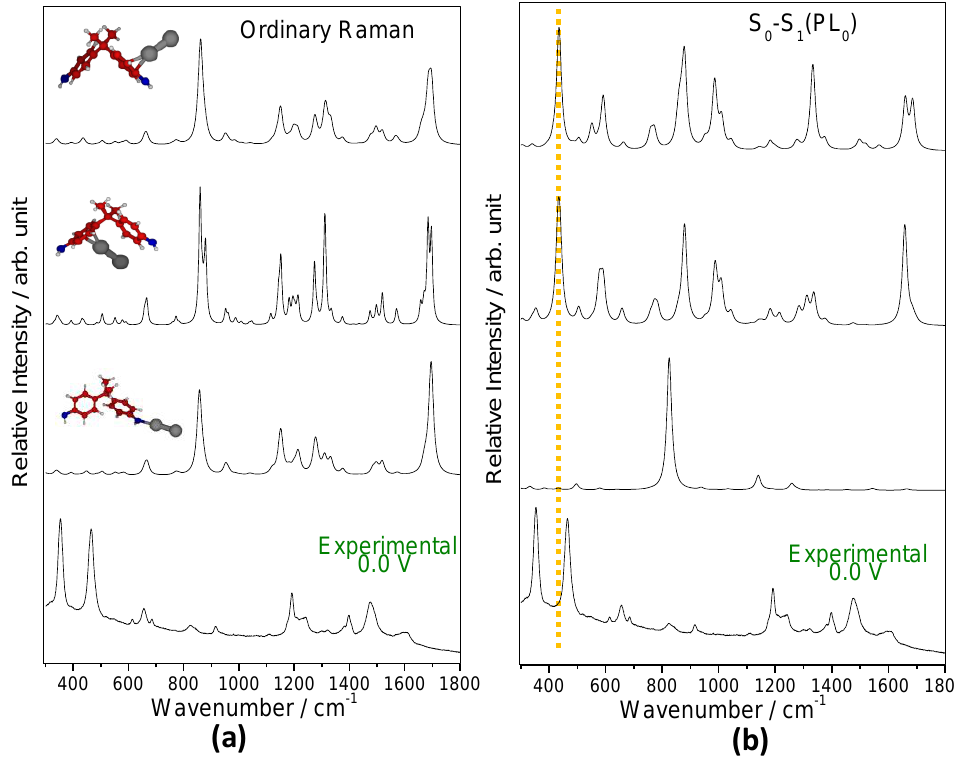
Figure 4 . Calculated ( a ) ordinary and ( b ) resonance Raman spectra of the Ag 2 -BPA complex with different silver coordination. SERS spectrum at 0.0 V is plotted at the bottom.